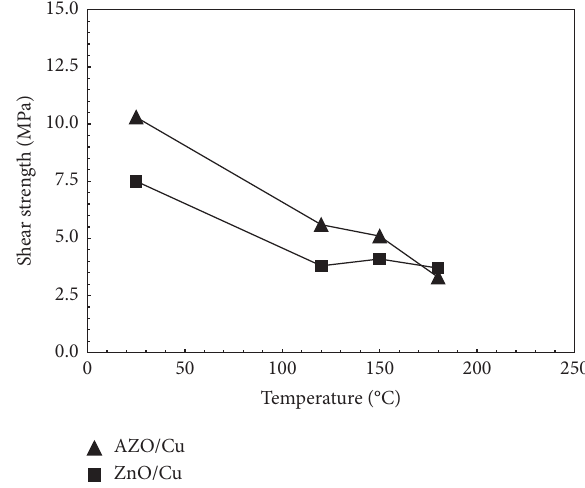
Figure 6: The shear strengths of AZO/copper and ZnO/copper joints bonded with Sn 8 Zn 3 Bi 1 Mg solder at various